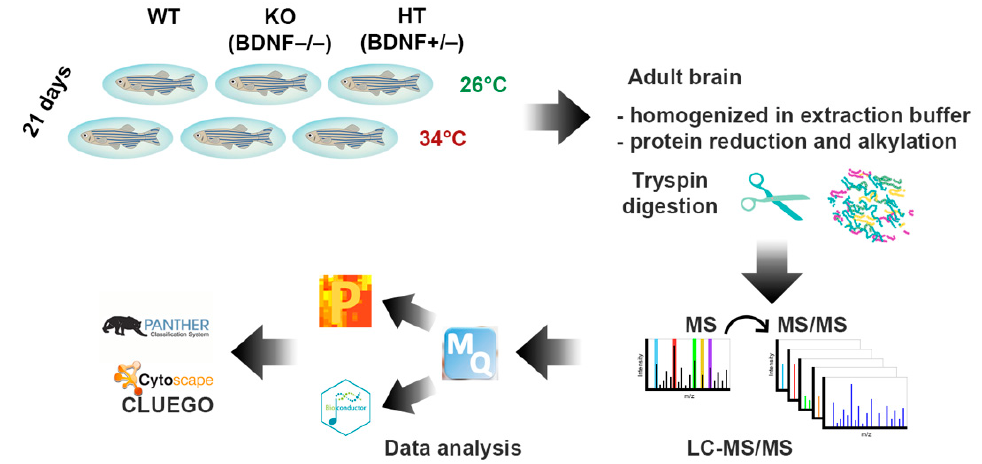
Figure 2. Cartoon of the workflow of the proteomic analysis of the brains of adult zebrafish kept for 21 days at 26 °C and 34 °C.